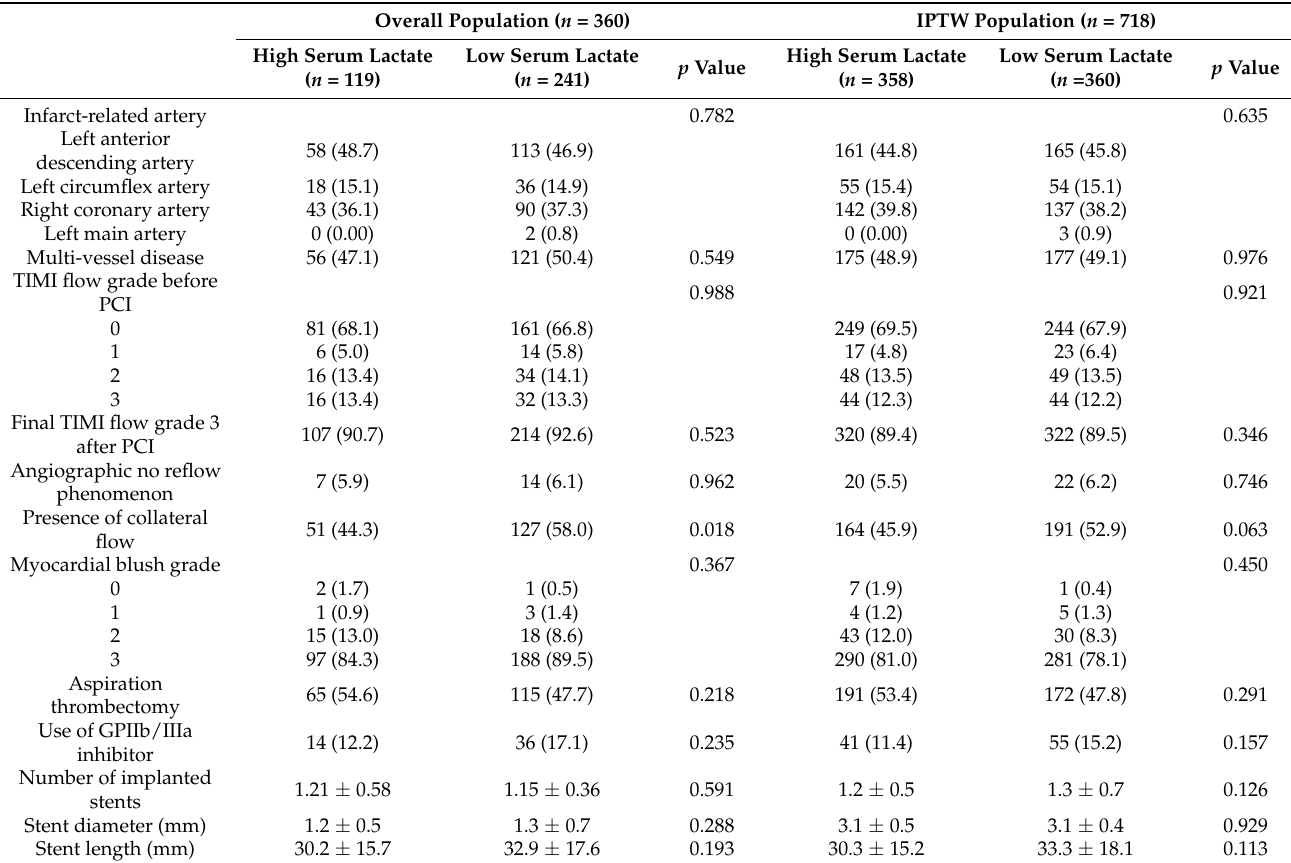
Table 2. Angiographic and procedural